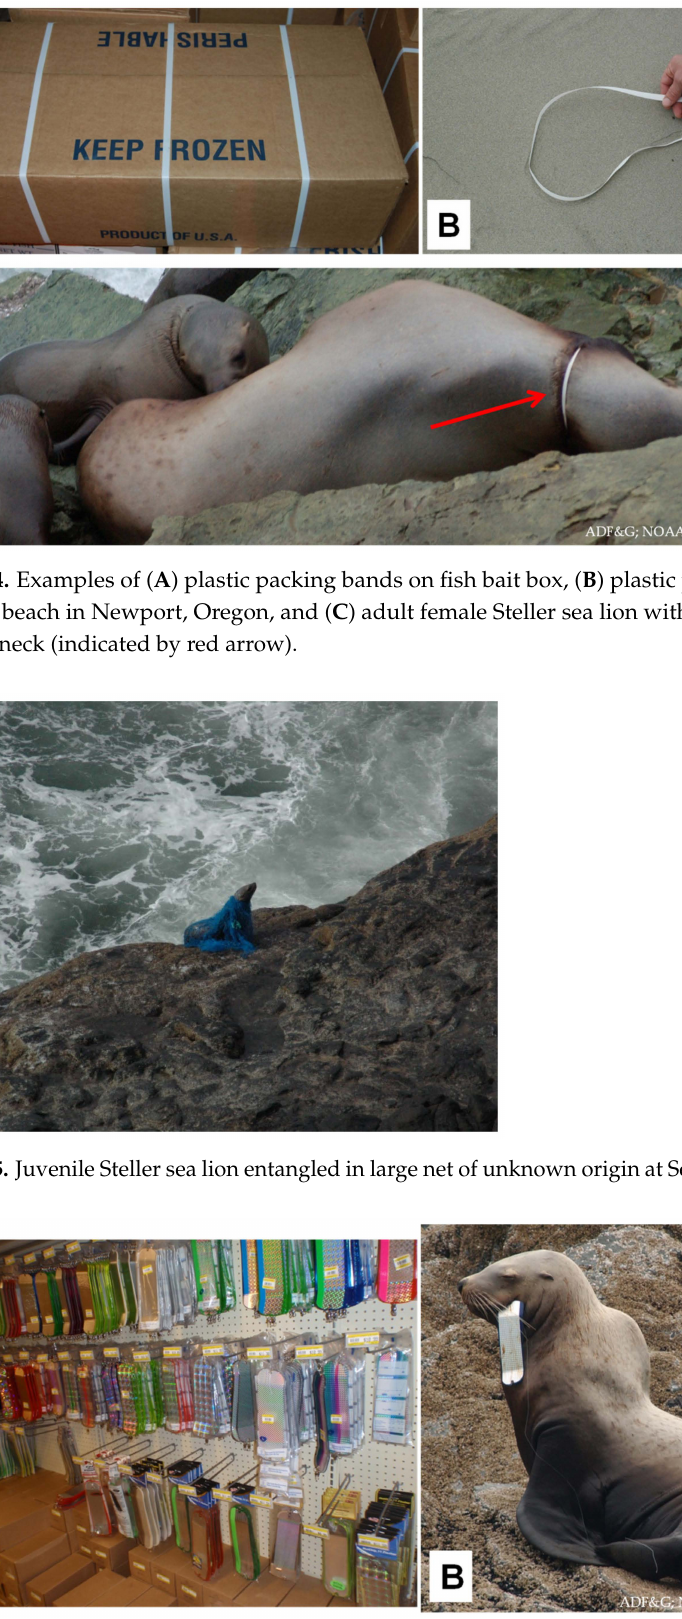
Figure 6. Example of ( A ) Salmon fishery flashers (lures) sold in a typical marine supply store, and ( B ) Steller sea lion that has swallowed a hook indicated by flasher lodged tightly against